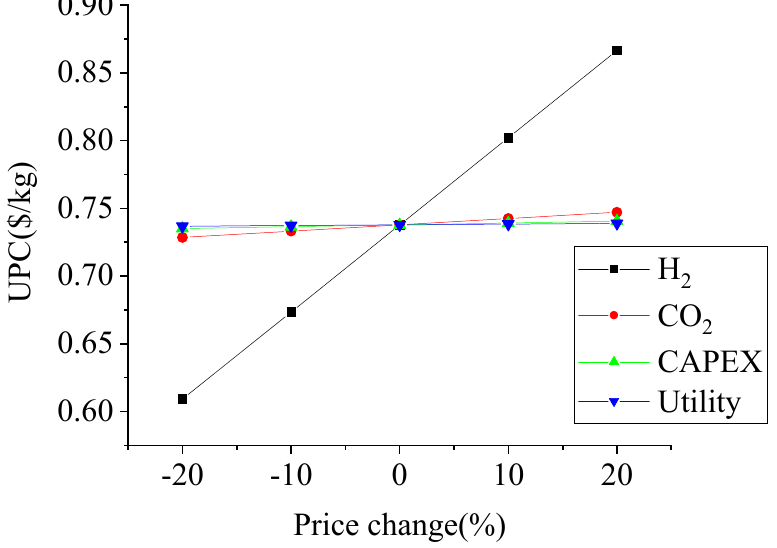
Figure 4. Sensitivity analysis of selected parameters for the methanol synthesis process model.